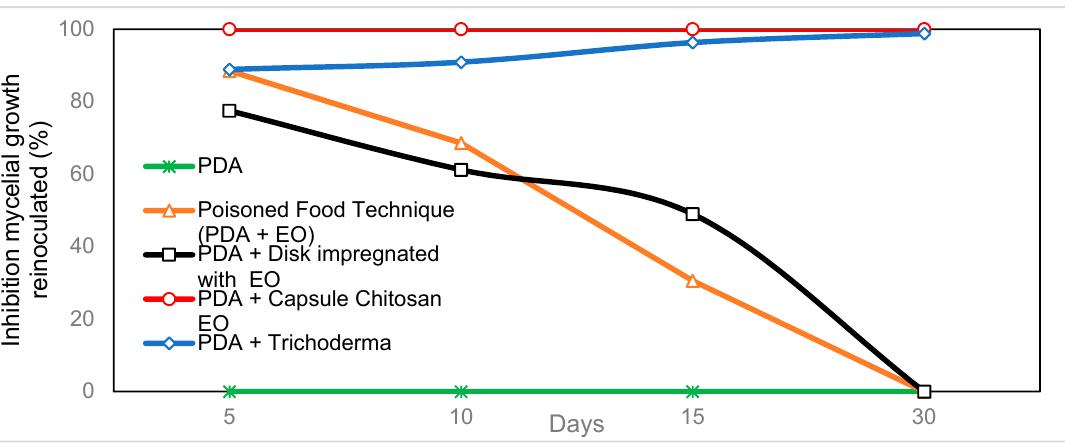
Figure 4. Comparison of the effectiveness of techniques using Cymbopogon citratus EO in the inhibition of mycelial growth of C. gloeosporioides up to 30 days. Table 2. Inhibition of C. gloeosporioides using different techniques up to 30 days.